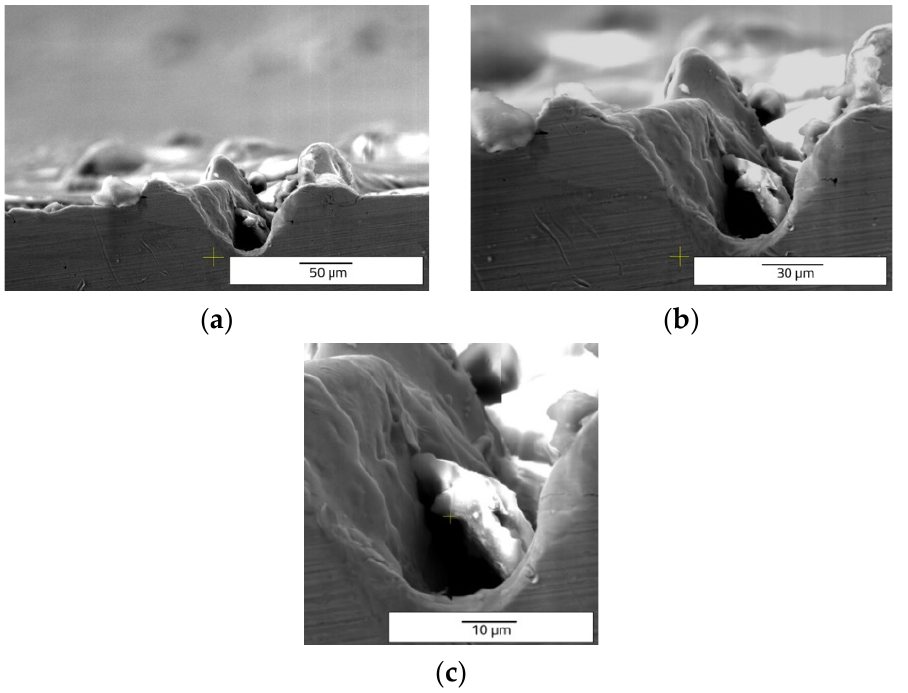
Figure 7. Cross section SEM images of octagonal donut shape (design type A) of LST, frequency 40 kHz, speed 400 mm/s, and no. of repetitions 10, magnification overview of the textured groove ( a ), magnification of the LST processed region ( b ), magnification of the hollow ( c ). Table 3. EDX elemental analysis of microtextured design octagonal donuts shape (design type A). Element